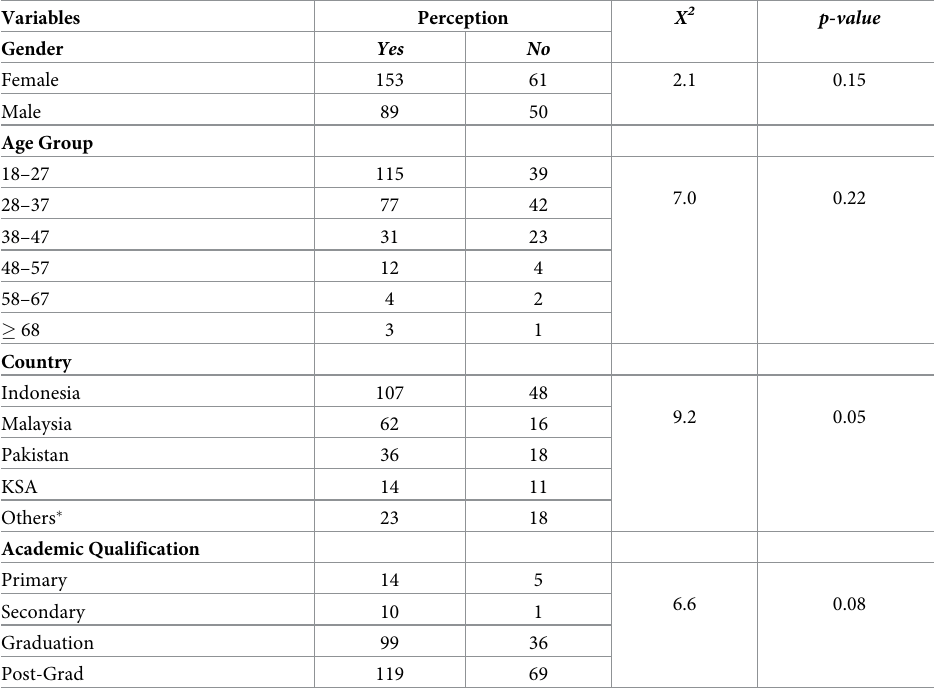
Table 7. Respondent’s perception regarding fatality of Omicron